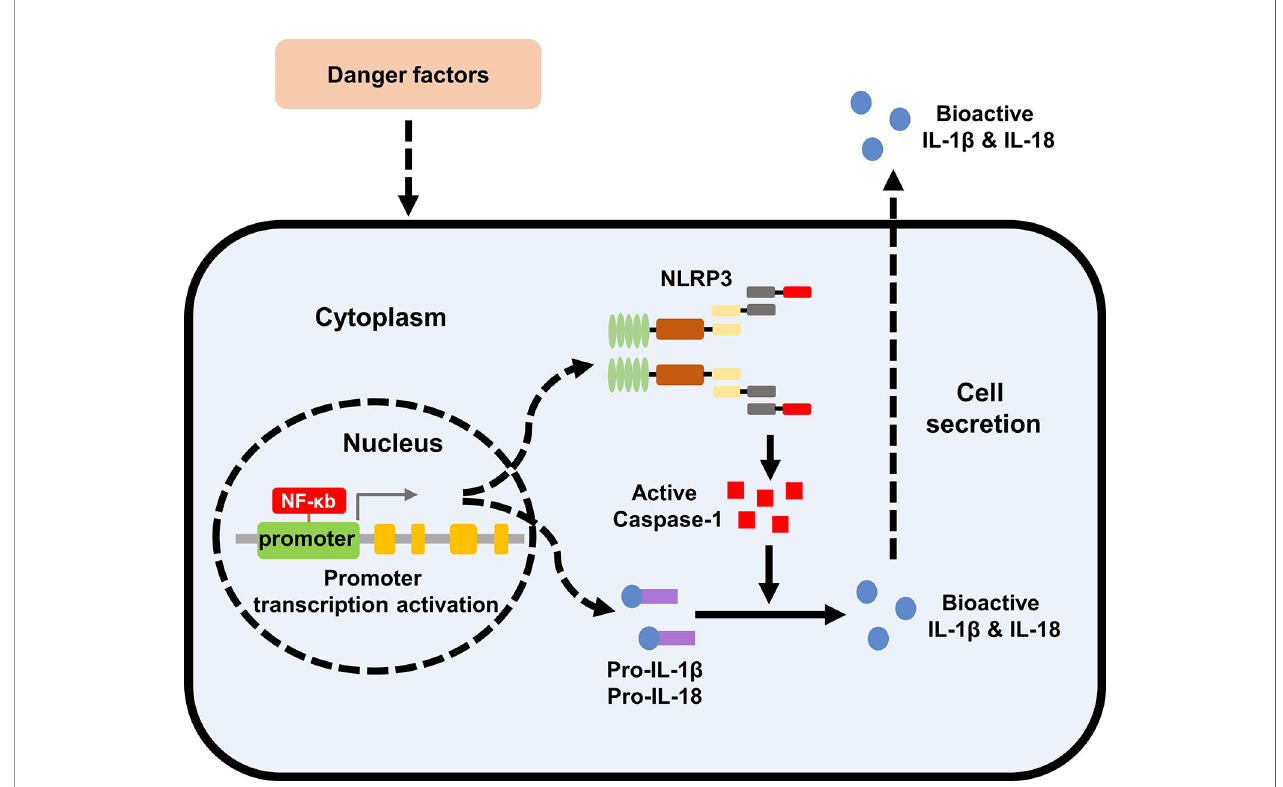
FIGURE 1 | Formation and activation of NLRP3 in fl ammasome. The effect of extracellular stimulating factors activates the intracellular NF- k B pathway. The activation of NF- k B pathway promotes the expression of in fl ammasome NLRP3, IL-1 b , and IL-18. The activation of the in fl ammasome NLRP3 promotes the activation of caspase-1, and the activated caspase-1 promotes the maturation of IL-1 b and IL-18, which are then secreted into the extracellular to exert biological effects. NLRP3, nod like receptor protein 3; IL,